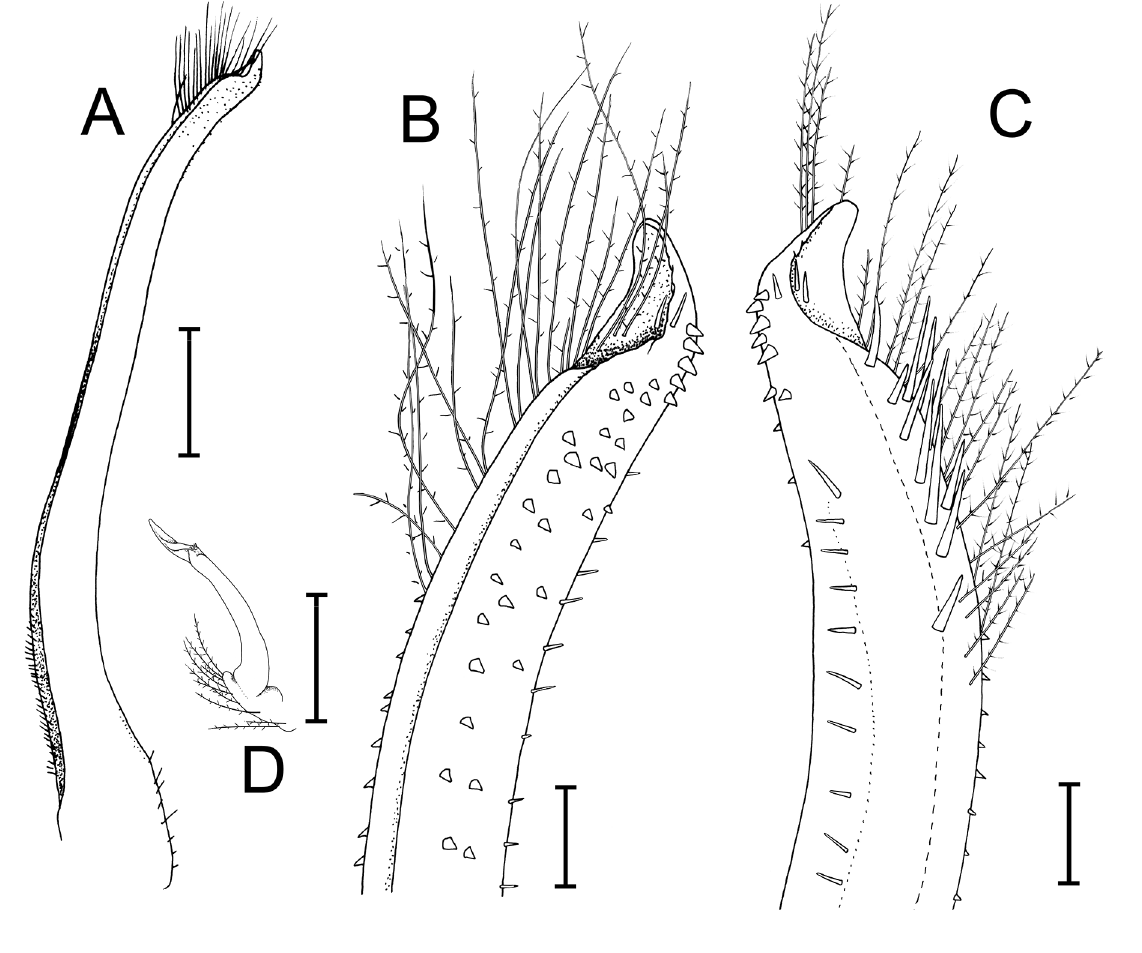
Fig. 10. Actaea spinosissima Borradaile, 1902, ♂, 8.9 × 6.6 mm (ZRC), Chagos Islands A . Ventral view of left G1. B . Ventral view of distal part of left G1. C . Dorsal view of distal part of left G1. D . Left G2. Scale bars: A, D = 0.5 mm; B–C = 0.1